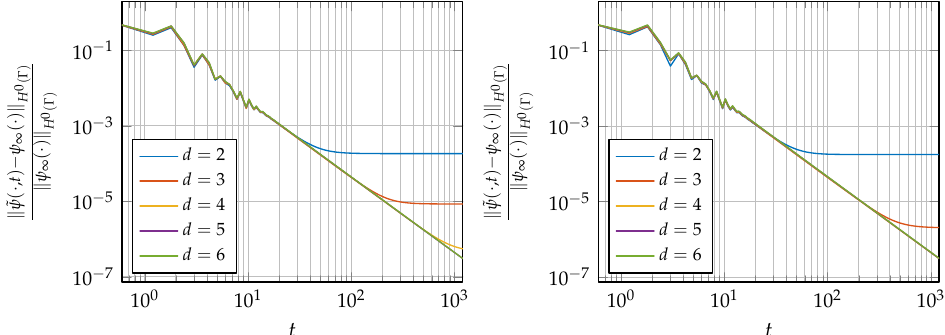
Figure 9. Time history of the relative error between transient and stationary solutions in the H 0 ( Γ ) norm for increasing degrees of B-spline (left) and Lagrangian (right) shape functions on a uniform spatial discretization of size ∆ α = π /10, having fixed ∆ t = 0.3. Table 6. Relative error in H 0 ( Γ ) norm at final time T = 1200 for B-spline and standard Lagrangian shape functions of different degrees, having a fixed space discretization step ∆ α = π /10 and time-step ∆ t = 0.3.